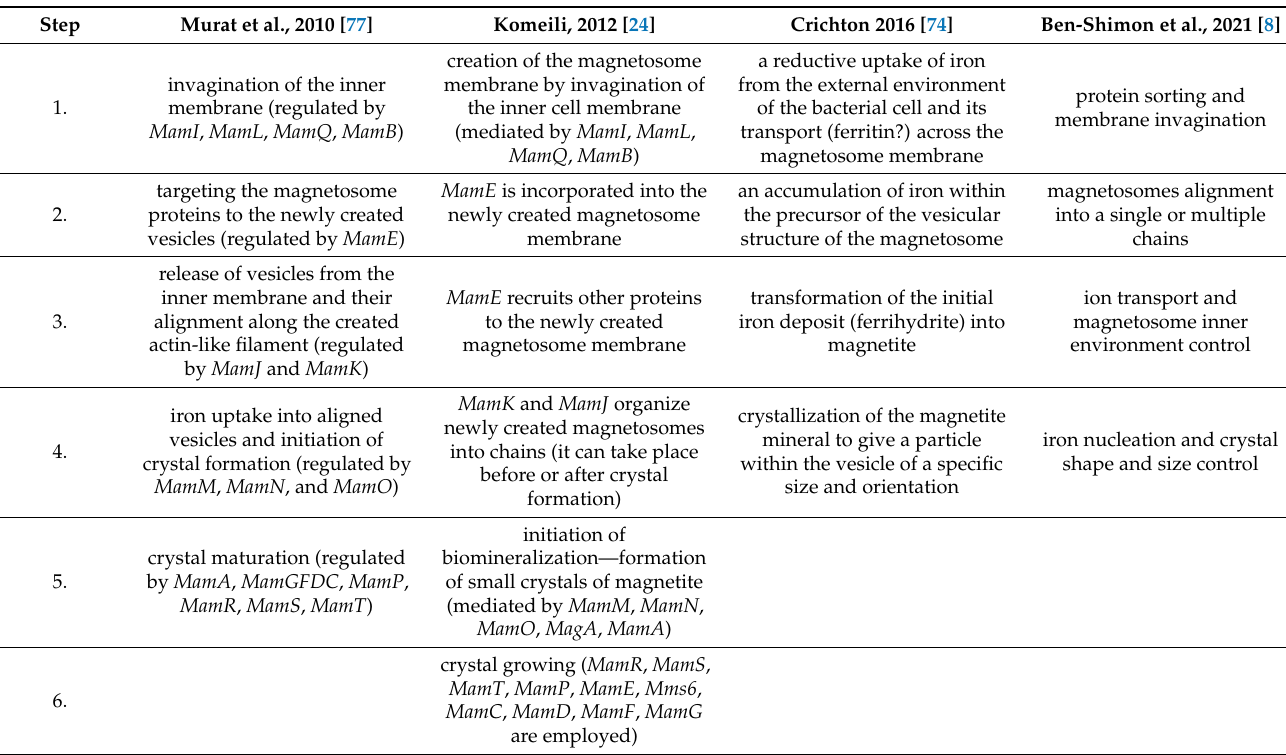
Table 1. Proposed mechanisms of magnetosome